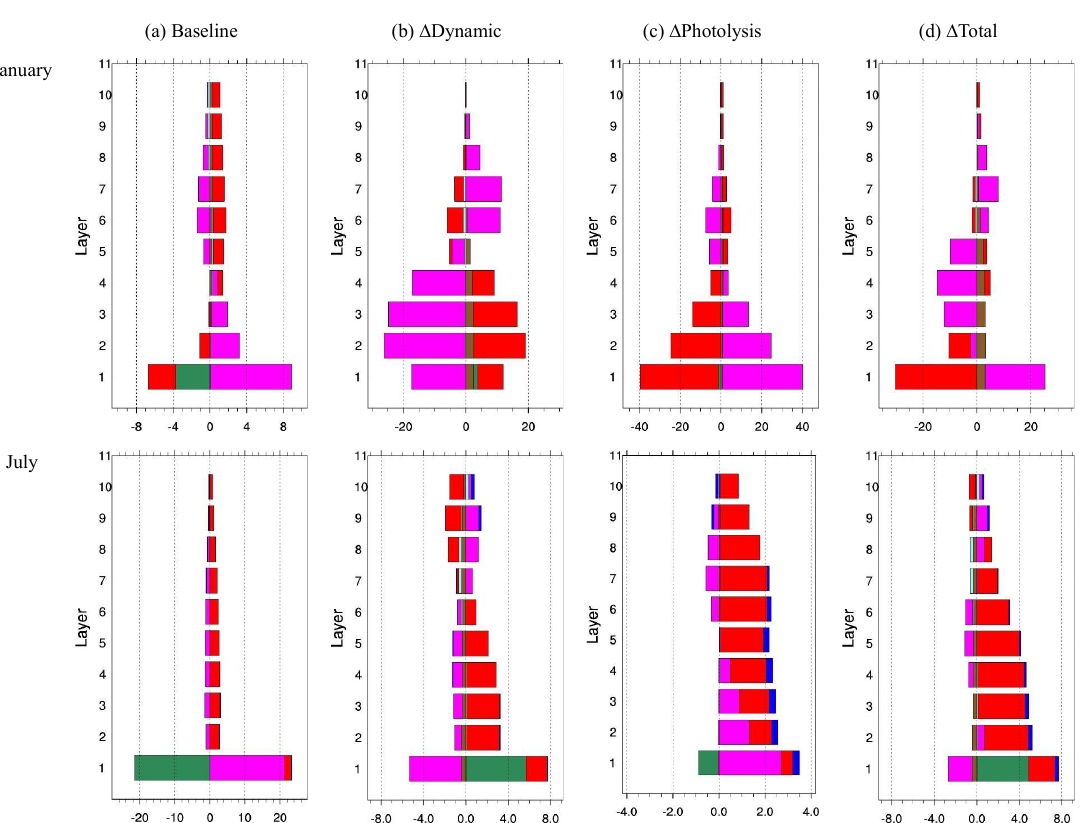
Figure 5. Vertical profile of integrated process contributions to surface O 3 concentration at noon in JJJ. Full-layer heights above ground are 40, 96, 160, 241, 355, 503, 688, 884, 1100 and 1357m; (a) baseline is the simulated O 3 in SimBL (unit: ppbh − 1 ); (b) (cid:49) Dynamic is the difference in normalized IPRs between SimSF and SimNF (unit: h − 1 ); (c) (cid:49) Photolysis is the difference in normalized IPRs between SimNF and SimBL (unit: h − 1 ); (d) (cid:49) Total is the difference in normalized IPRs between SimSF and SimBL (unit: h − 1